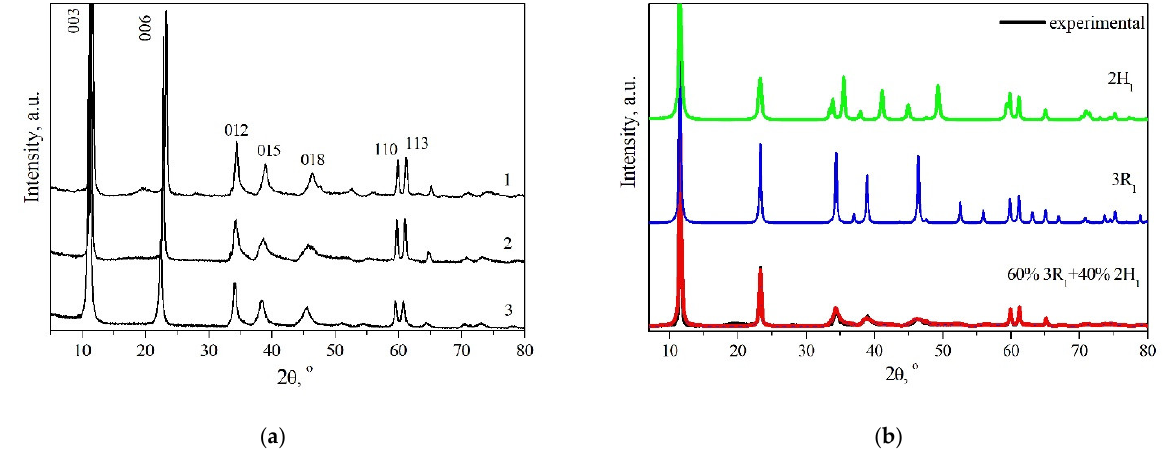
Figure 1. XRD patterns of the initial MgGa-CO 3 LDHs with different mole fractions of Mg 2+ ( a ) (1—0.67; 2—0.75; 3—0.80) and simulated XRD pattern for a sample with Mg 2+ = 0.67 ( b ).